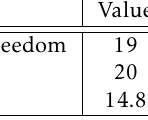
Figure 8. Correlation between SUS Score and Farmer’s